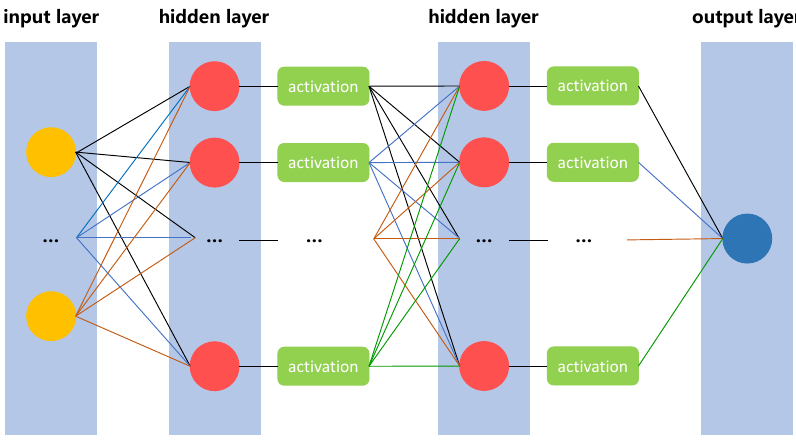
Figure 4. The structure of the MLP model, where the circles represent neurons, and the lines represent the connections between